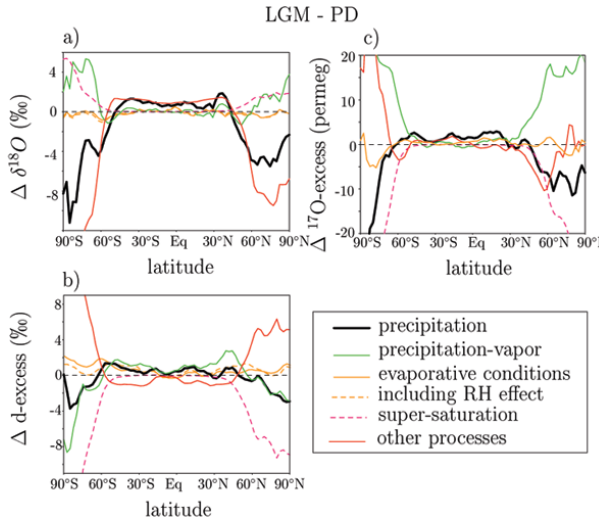
Fig. 10. Same as Fig. 8, but for LGM-PD difference. When the black line is positive, the δ 18 O , d-excess or 17 O -excess values are higher in LGM than in PD. When the colored curves are of the same sign as the black curves, then the corresponding process contributes pos- itively to the total LGM-PD